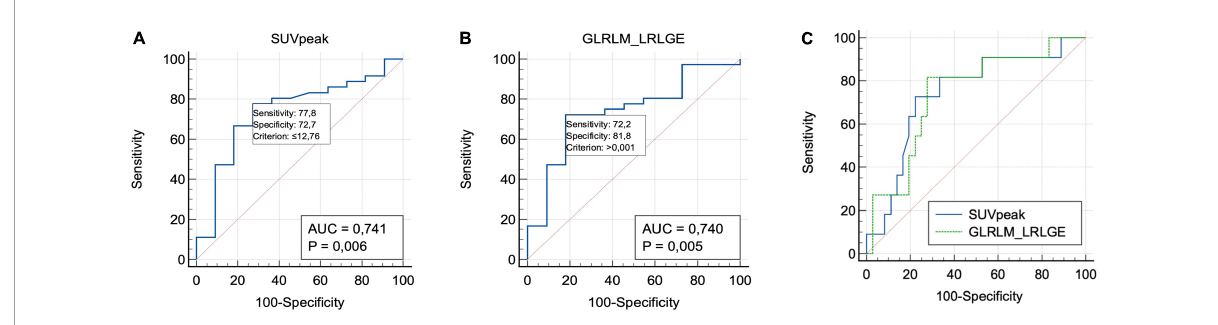
FIGURE1 Receiver operating characteristic curve analyses of SUVpeak (A) , GLRLM_LRLGE (B) , and both (C) value for predicting overall